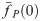
Community selection can be stalled by routine experimental procedures, and can succeed when community function correlates with its heritable determinant or when using the top-tier strategy.(A–I) Evolution dynamics when the maturation time T was sufficiently short to avoid Resource depletion and stationary phase (T = 17). (A–C) Adults were chosen using the top-dog strategy and diluted into progeny Newborns as if via pipetting (i.e., H and M biomass fluctuated around their expected values). Community selection was not effective: Average fp and community function failed to improve to their theoretical optima. Community function poorly correlated with its heritable determinant f¯P(0) (the average cost paid by M in Newborn). Black and magenta dots: unchosen and chosen communities from 1 selection cycle, respectively. (D–F) Adults were chosen using the top-dog strategy. A fixed H biomass and a fixed M biomass from a chosen Adult were allocated into each progeny Newborn as if using a cell sorter. Community selection was successful. Community function also correlated with its heritable determinant f¯P(0). Here, Newborn total biomass BM(0) and fraction of M biomass ϕM(0) were, respectively, fixed to BMtarget = 100 and ϕM(T) of the parent Adult of the previous cycle. (G–I) When we chose the top 10% Adults and let each reproduce 10 Newborns as if via pipetting, community function improved somewhat despite poor correlation between community function and its heritable determinant f¯P(0). For selection dynamics over many cycles, see S14 Fig. (J–L) Evolution dynamics when maturation time was long (T = 20) such that, by the end of T, most Resource was consumed (stationary phase). Adults were chosen using the top-dog strategy and reproduced as if via pipetting. Community selection was successful due to high correlation between community function and its heritable determinant f¯P(0), assuming that variable time in stationary phase would not introduce nonheritable variations in community function. Black, cyan, and gray curves represent independent simulation trials. P¯(T) was the average of P(T) across all chosen Adults. f¯P(T) was obtained by first averaging among M within each chosen Adult and then averaging across all chosen Adults. The simulation codes can be found in S2 Code, and the data can be found in S1 Data. Adult, Adult community; H, Helper; M, Manufacturer; Newborn, Newborn community.